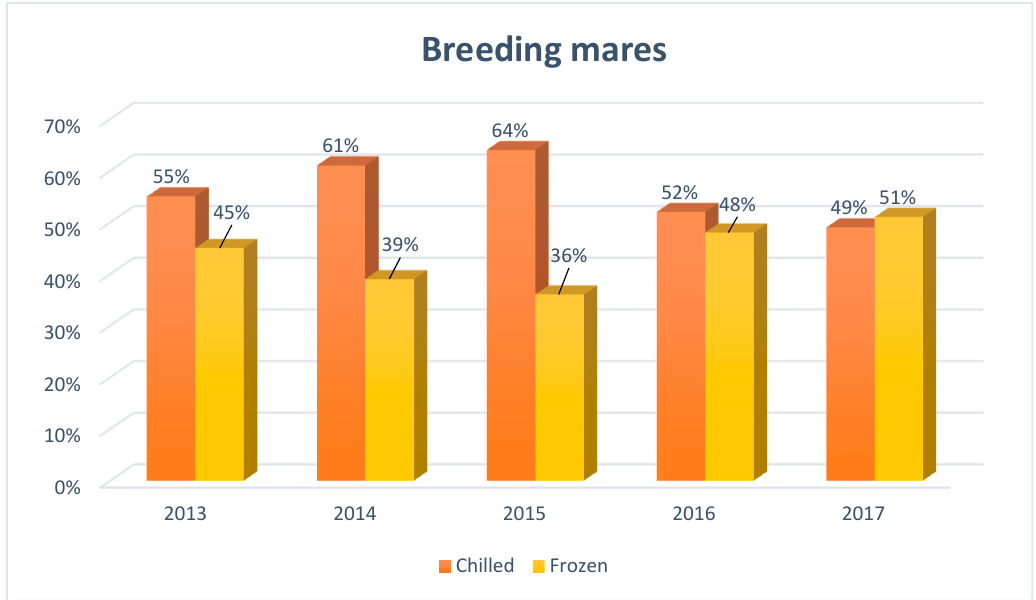
Figure 2. The structure of insemination of breeding mares in Europe, including the division into the type of semen used for artificial insemination ( N = 2480), developed based on reports from European insemination stations.